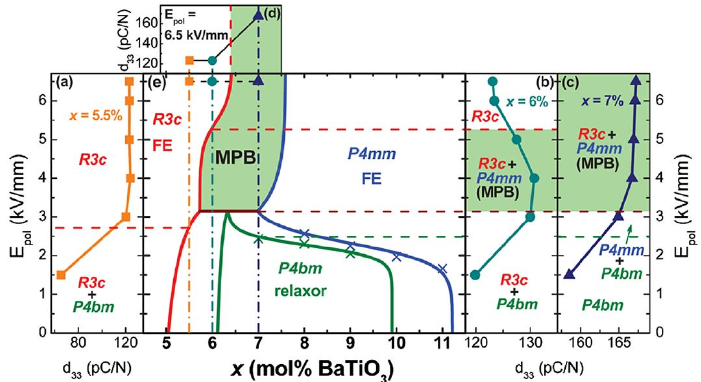
Figure 18. Electric field modulated BNBT phase diagram. Ferroelectric R 3 c , relaxor P 4 bm and ferroelectric P 4 mm regions in the composition-electric field space are identified. Plots of the piezoelectric coefficient d 33 as function of the electric field intensity, for selected compositions, are included. Reproduced with permission from [110].